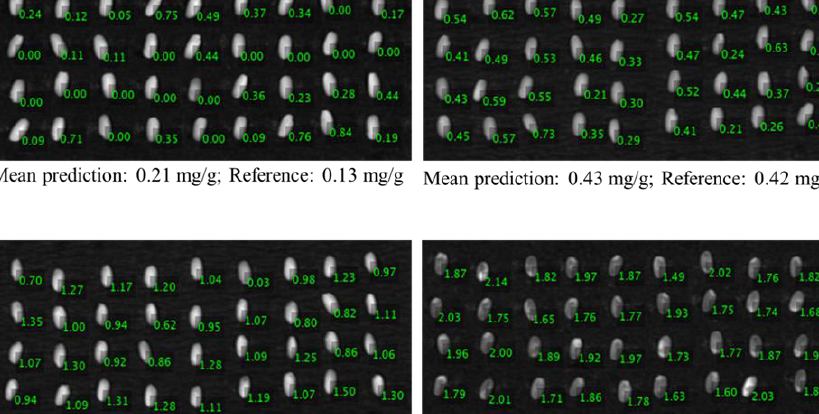
could not distinguish the group of seeds based on the anthocyanins content due to the